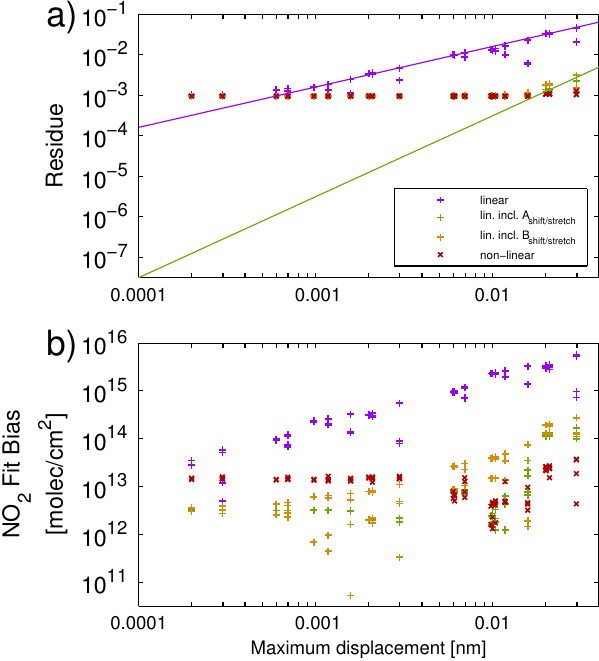
Fig. 5. Dependency of the peak-to-peak fit residue (a) and the abso- lute NO 2 bias (b) on the maximum spectral displacement caused by the combined shifts and stretches applied, for the non-linear and various linear fits, on a log-log-scale. The purple and green lines indicate the estimated first and second order effects of a spec- tral displacement, according to Eqs. (9) and (12), for a = 0 . 4 and ς = 0 . 3nm.